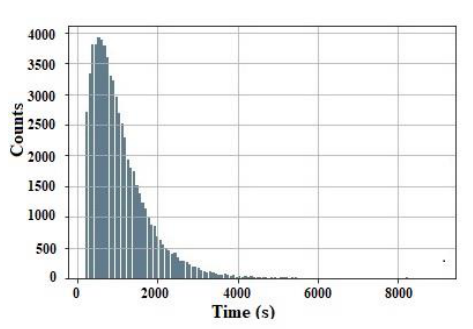
Figure 8. Frequency histogram of travel time consumption.